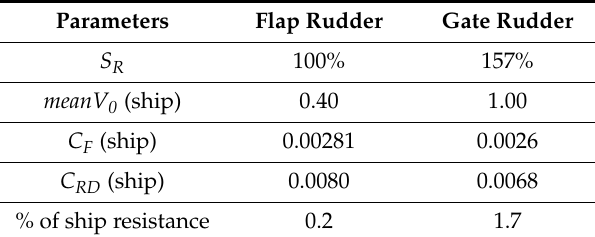
Table 3. Rudder drag calculations (in full scale).